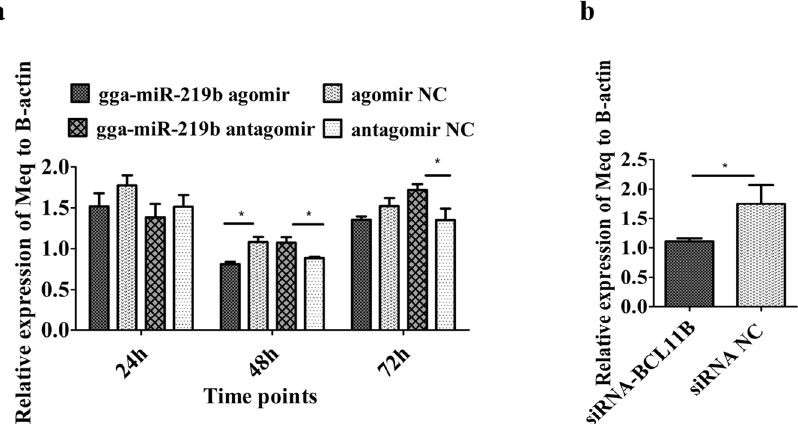
Figure 6. Effect of Meq gene expression on MD lymphoma transformation. ( a ) mRNA expression level of Meq after transfecting the miRNA agomir, antagomir or respective NC into MSB1 cells at 24 h, 48 h and 72 h (n = 4). ( b ) mRNA expression level of Meq after transfecting siRNA-BCL11B and siRNA NC into MSB1 cells at 48 h (n = 4). Differences between two groups were analysed by Student’s t -test with the SAS system. The data are expressed as the mean ± S.E. * P < 0.05. ** P <